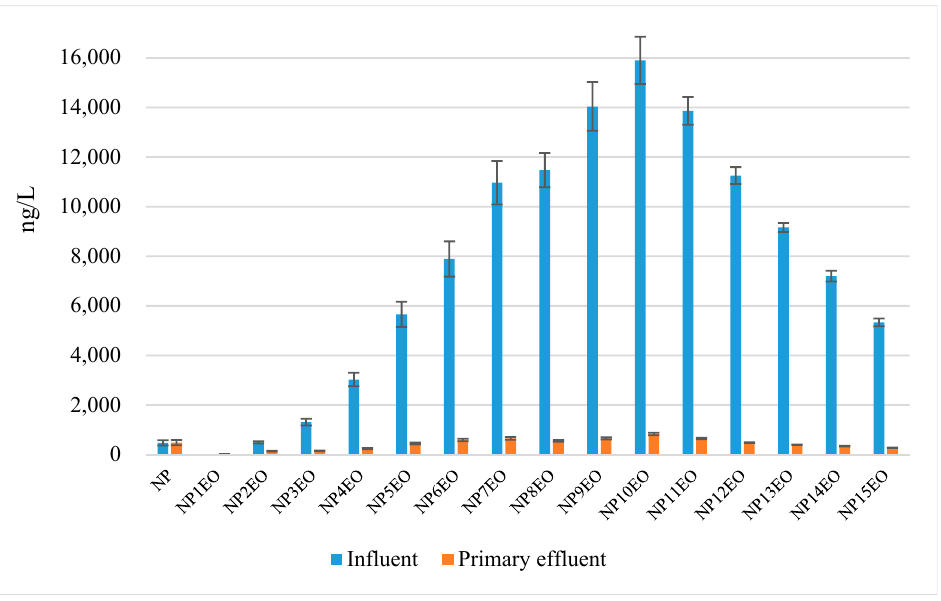
Figure 5. Concentration of NP and individual NP n EO for F1.